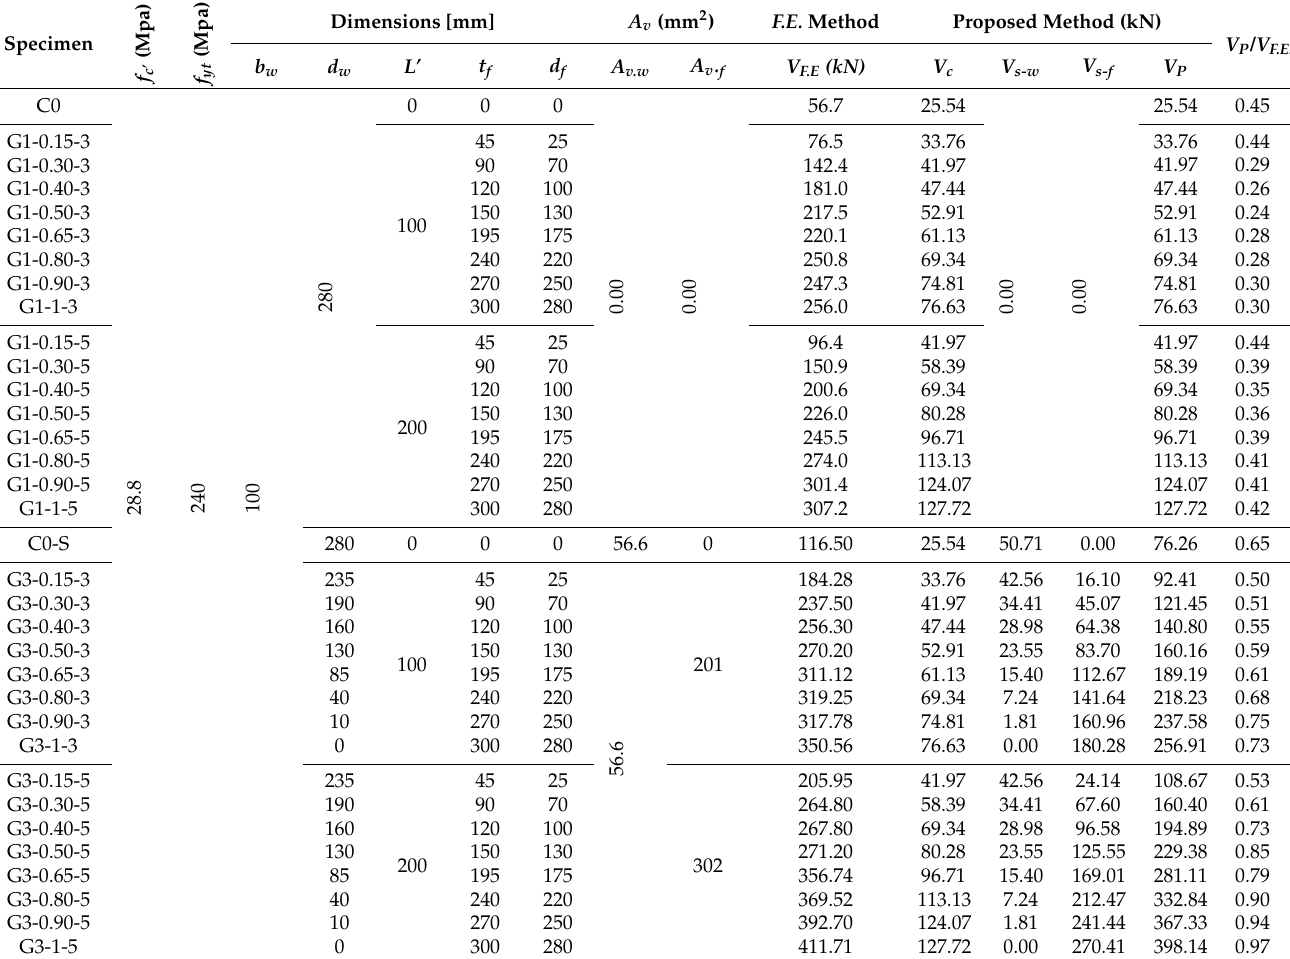
Table 3. Verification of proposed equation with FE results *.